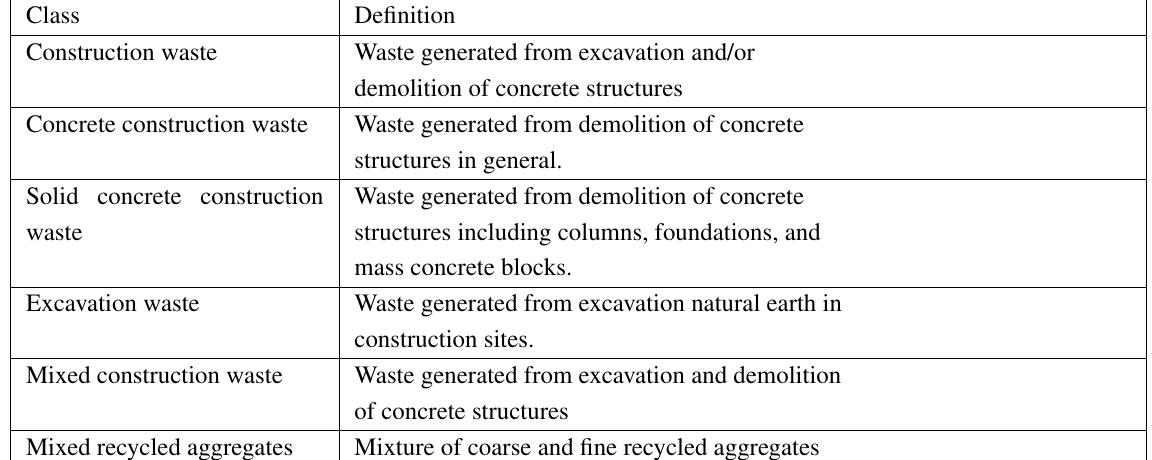
Table 8. Construction waste classification according to Gulf